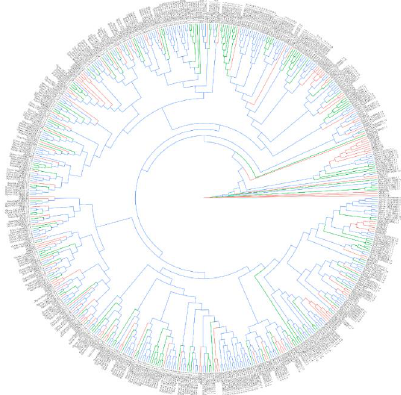
Figure 3. Phylogenetic analysis of ATP-binding cassette (ABC) transporters from G. max , S. lycopersicum and A. thaliana . The amino acid sequences of the ABC transporters identified from G. max